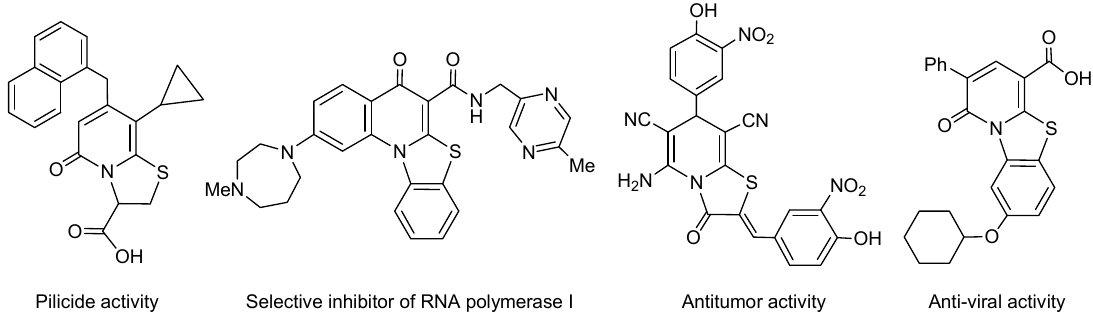
Figure 1. Known biologically active compounds structurally related to the [1,3]thiazolo[3,2-a]pyridinium scaffold. The reactions of 2-pyridinesulfenyl and 2-pyridineselenenyl chlorides with some alkenes have 3-phenyl-2 Н ,3 Н -[1,3]thiazolo- and -selenazolo[3,2- а ]pyridin-4-ium chlorides in high yields [32,35].